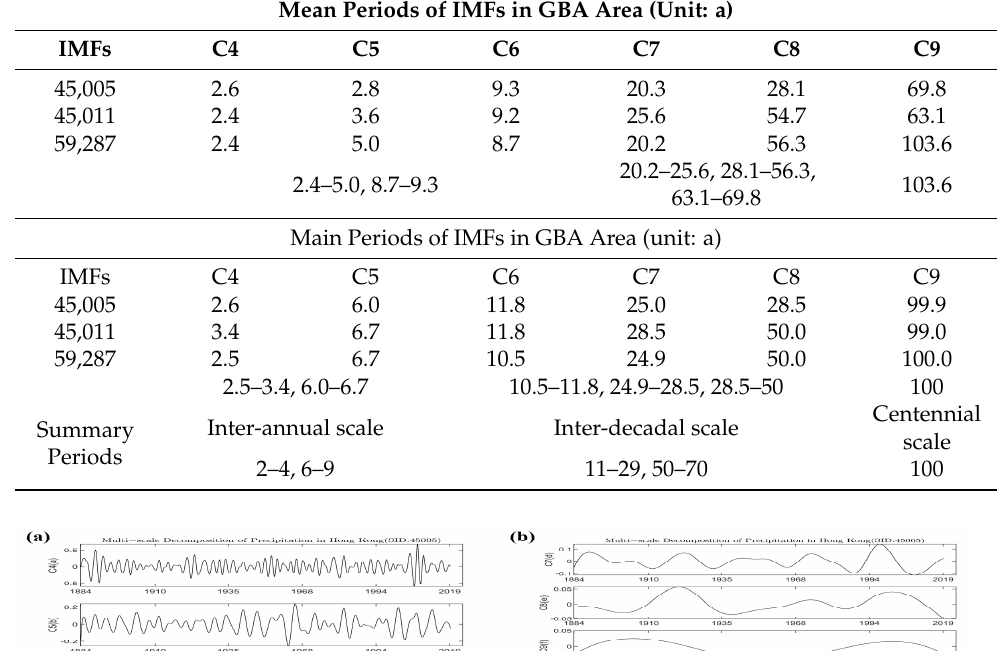
Table 7. Multi-scale periodic analysis of precipitation in The Guangdong–Hong Kong–Macao Greater Bay (GBA).